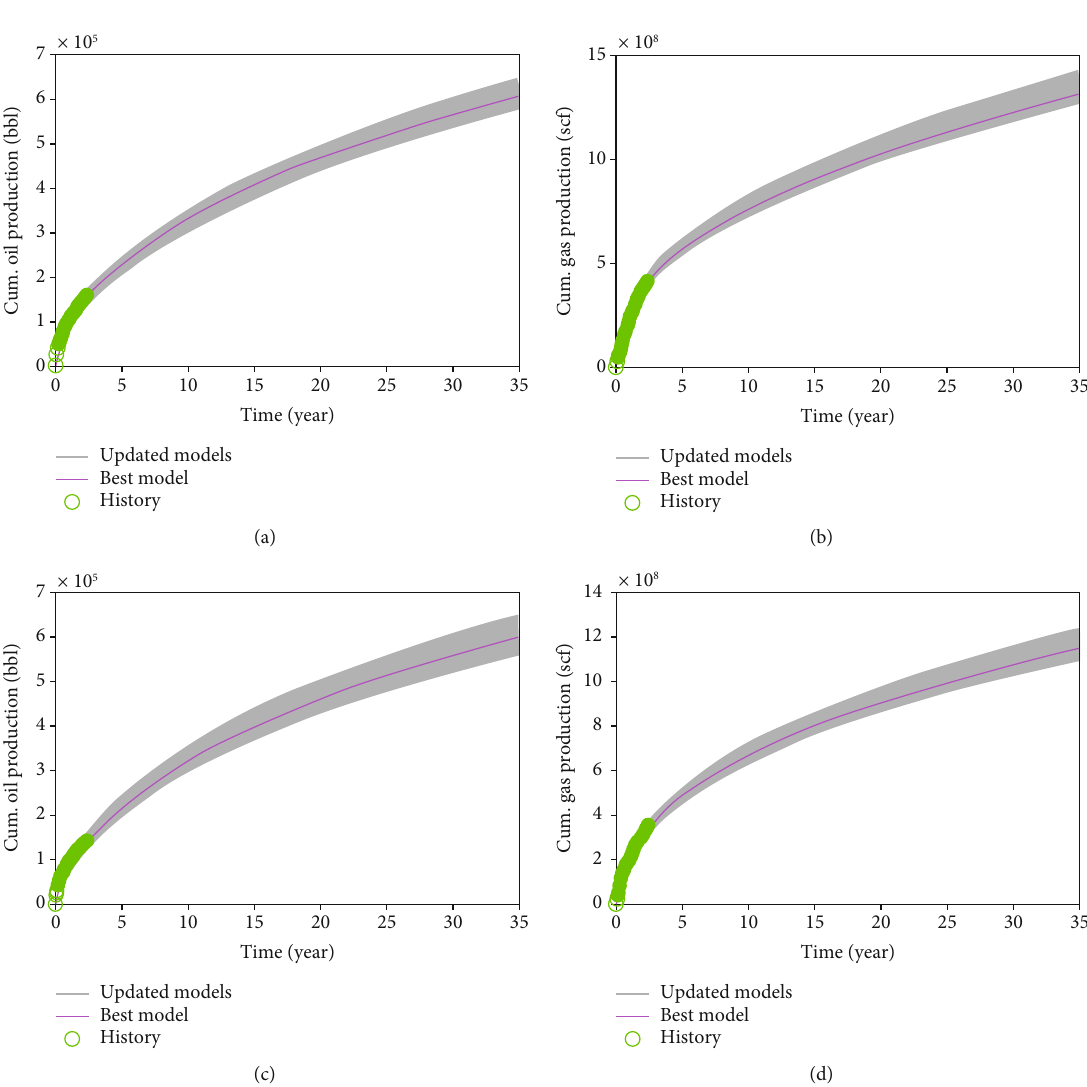
Figure 13: Cumulative oil and gas production forecasting of top 50 history-matched models: (a) cumulative oil production for well A, (b) cumulative gas production for well A, (c) cumulative oil production for well B, and (d) cumulative gas production for well